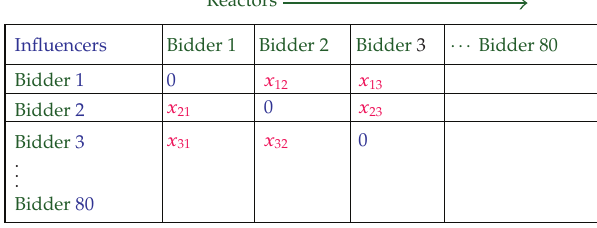
Figure 2: Socio Matrix of Influencers and